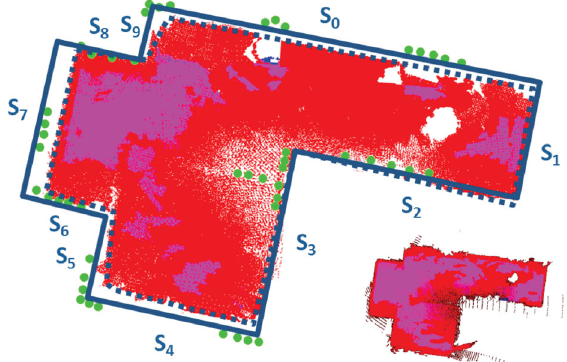
Fig. 7 Shape optimization. We exploit the data labeled as wall to optimize the room shape. Differences and points are emphasized to illustrate the method (D4: open space room example, see Section 7). Bottom right: footprint shape before filtering (see Section 6.2).